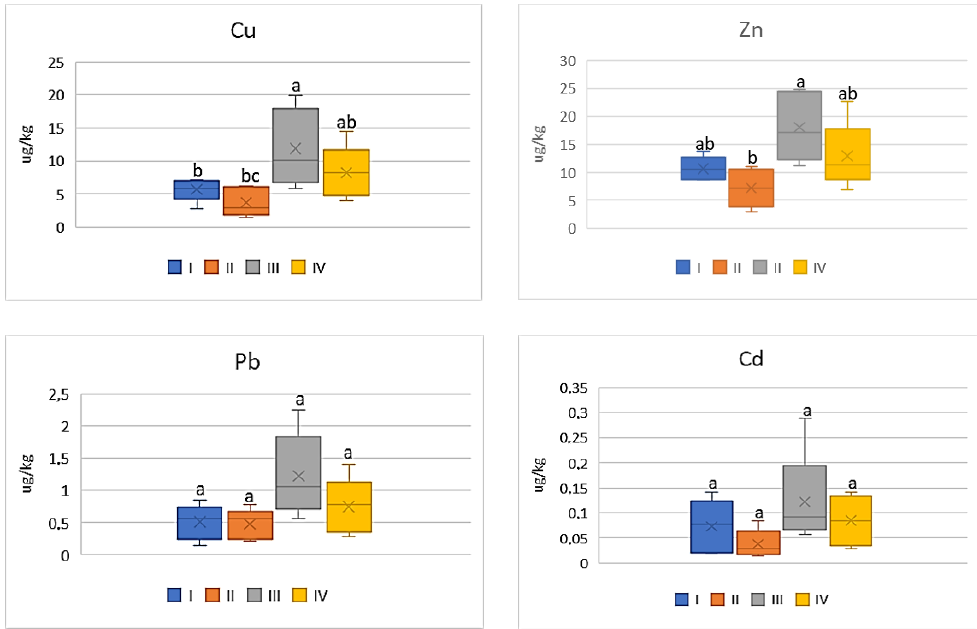
Figure 8. DIM values for tomato depending on the metal and study zone. The same letters mean no significant differences between the values.